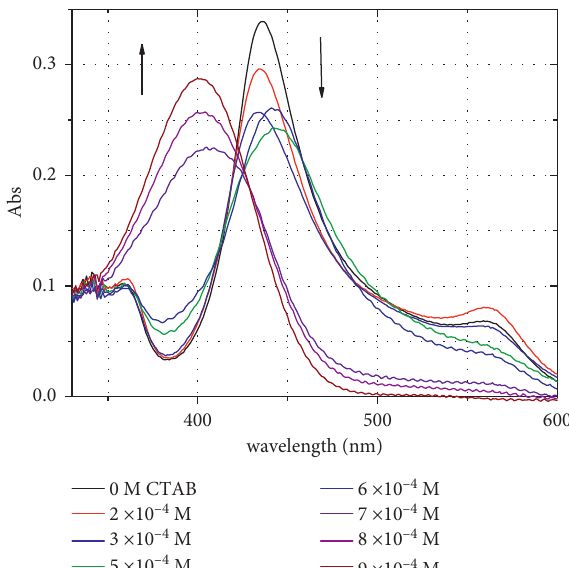
Figure 13: Absorption spectra of coumarin 3 (1 × 10 − 5 M) in 10% ethanolic aqueous solutions with increasing cetyl trimethyl ammonium bromide (CTAB)